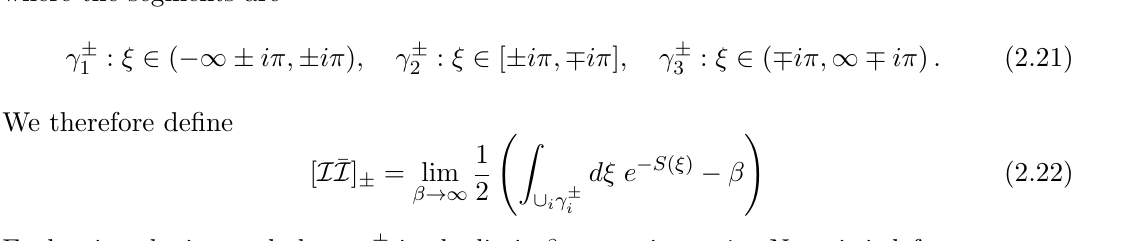
Figure 1 . The Lefschetz thimbles for the I (cid:22) I saddle, showing the downward (cid:13)ows (blue curves) connecting (cid:28) to (cid:28) when g ! g e i(cid:18) with (cid:18) ! 0 + . The red curves are the corresponding upward 0 1 (cid:6) (cid:13)ows. The directions are (cid:13)ipped about the imaginary axis for (cid:18) ! 0 where the segments